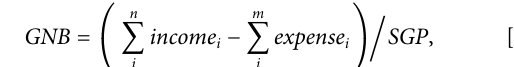
TABLE 2 | Factories with ethanol capacity (CONADESUCA, 2020). ZIP code